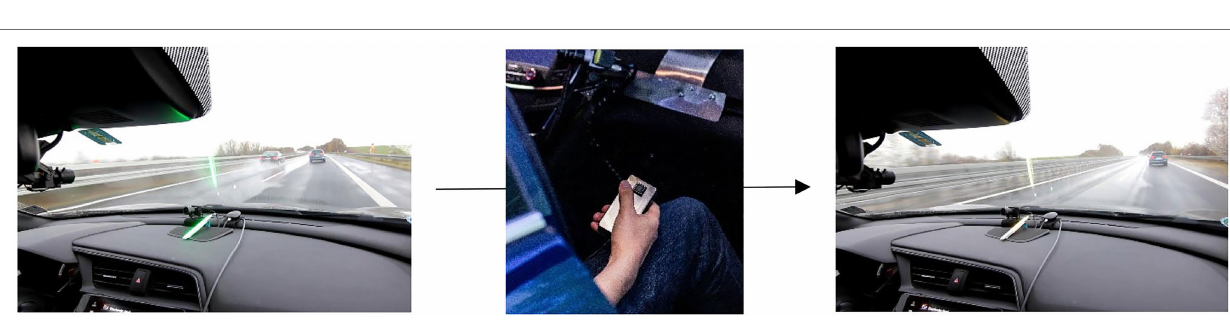
FIGURE 3 | Color transition from green to orange caused by a button press of the